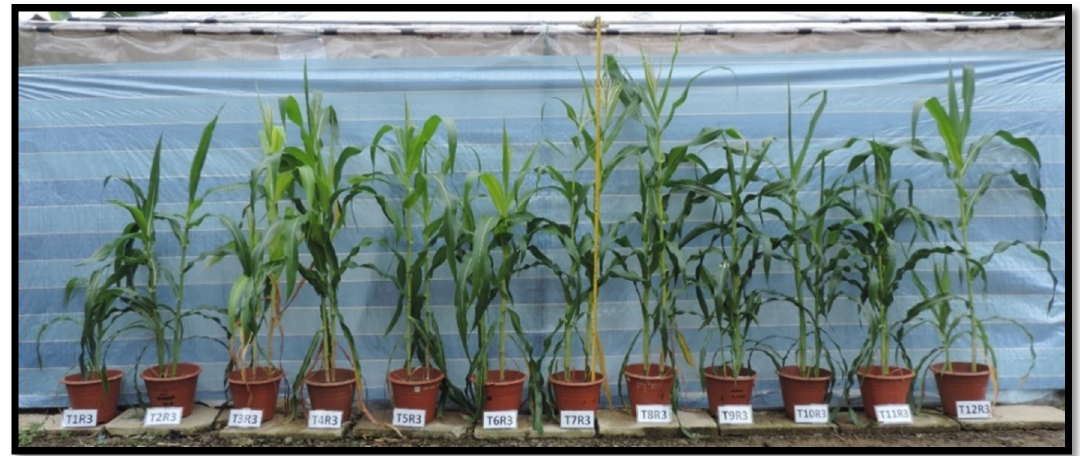
Figure 2. Effects of treatments on maize plants at tasseling stage.